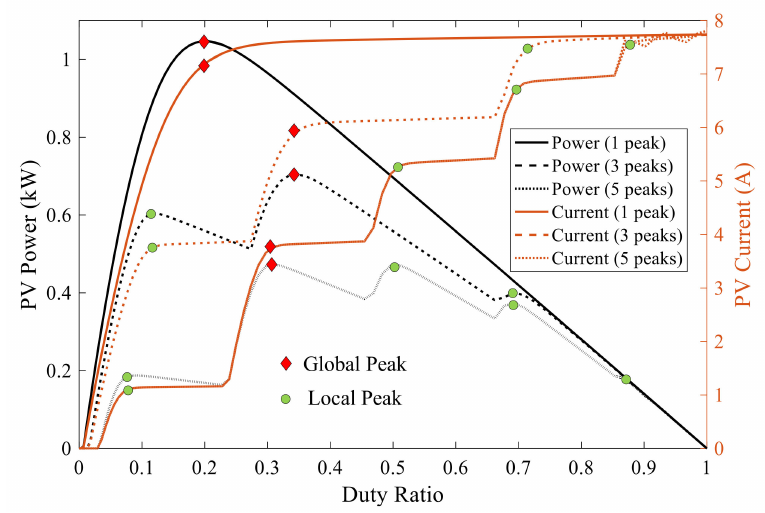
Figure 3. The I-d and P-d characteristics of 5 PV modules in series when boost converter is